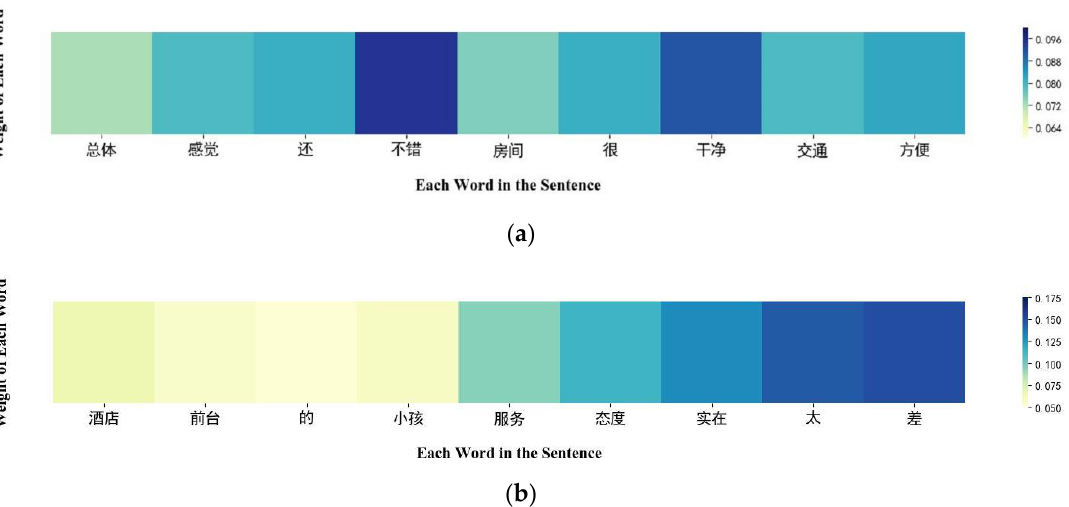
Figure 5. ( a ) Text 1 attention weight heatmap (“ 总体 ( The overall)” “ 感觉 ( feeling)” “ 还 ( still)” “ 不 错 ( good)” “ 房间 ( room)” “ 很 ( very)” “ 干净 ( clean)” “ 交通 ( traffic)” “ 方便 ( convenient)”) ; ( b ) (good)” “ 房间 (room)” “ 很 (very)” “ 干净 (clean)” “ 交通 (traffic)” “ 方便 (convenient)”); ( b ) Text 2 Text 2 attention weight heatmap (“ 酒店 ( The hotel)” “ 前台 ( f ront desk)” “ 的 ( the)” “ 小孩 ( child)” attention weight heatmap(“ 酒店 (The hotel)” “ 前台 (front desk)” “ 的 (the)” “ 小孩 (child)” “ 服务 “ 服务 ( service)” “ 态度 ( attitude)” “ 实在 ( reality)” “ 太 ( too)” “ 差 (terrible )”) . (service)” “ 态度 (attitude)” “ 实在 (reality)” “ 太 (too)” “ 差